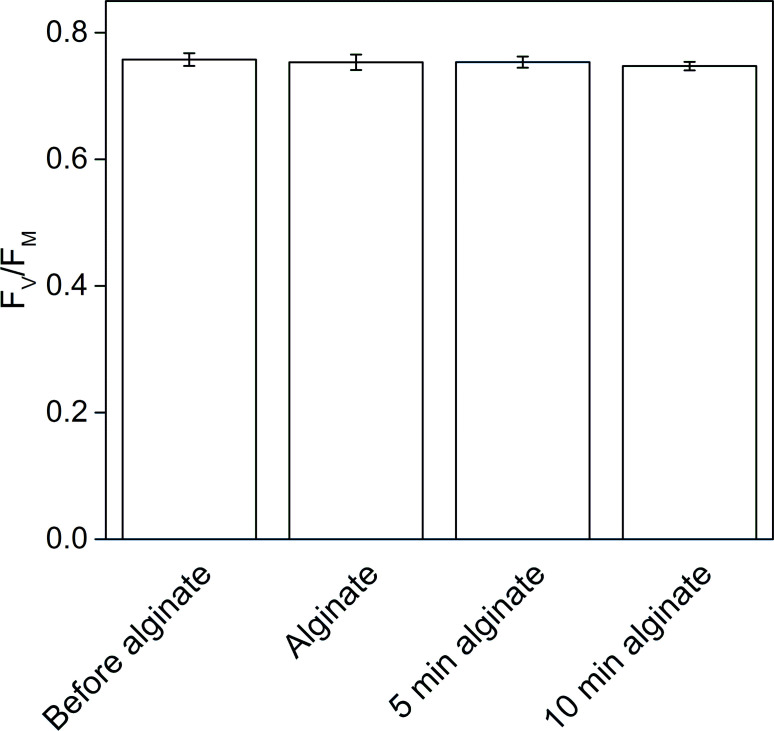
The effect of alginate fixation on the maximum quantum yield of PSII (FV/FM).Slug individuals were separately fixed in alginate and FV/FM was monitored before the fixation, immediately after the fixation, and after 5 and 10 min in fixation. The slugs had been in the dark for 20 min before the first measurement and another 20 min dark period preceded the alginate fixation. The rest of the measurements were done at 5 min intervals, keeping the samples in the dark between the measurements. All data are averages from three biological replicates, and the error bars indicate SE.